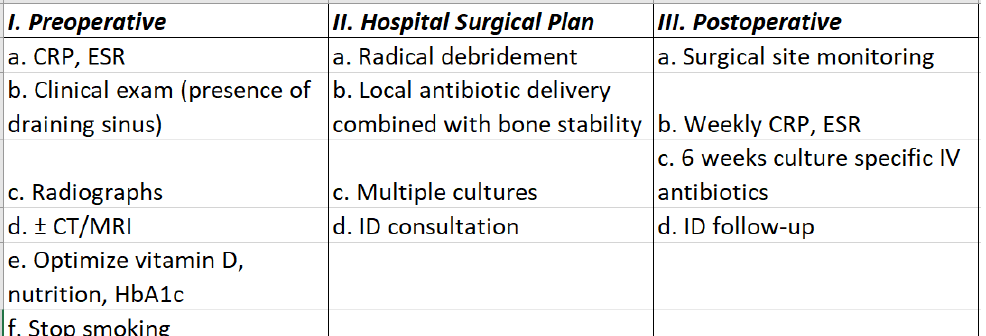
Figure 2. Workflow diagram. CRP, C-reactive protein; CT, computed tomography; ESR, erythrocyte sedimentation rate; HbA1c, blood sugar; ID, infectious diseases; IV, intravenous; MRI, magnetic resonance imaging.